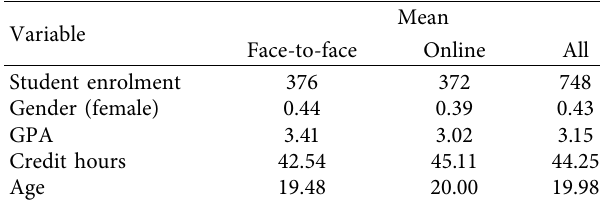
Table 1: Sample demographic and independent variables separated by instruction